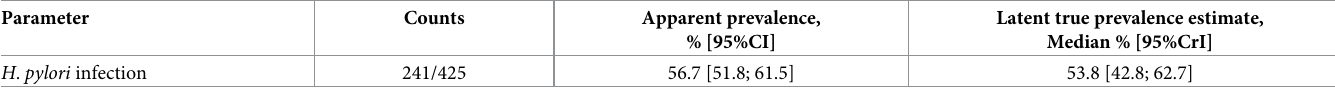
Table 4. Bayesian estimation of the latent true prevalence of the H . pylori infection and the dyspeptic syndrome in the study population.